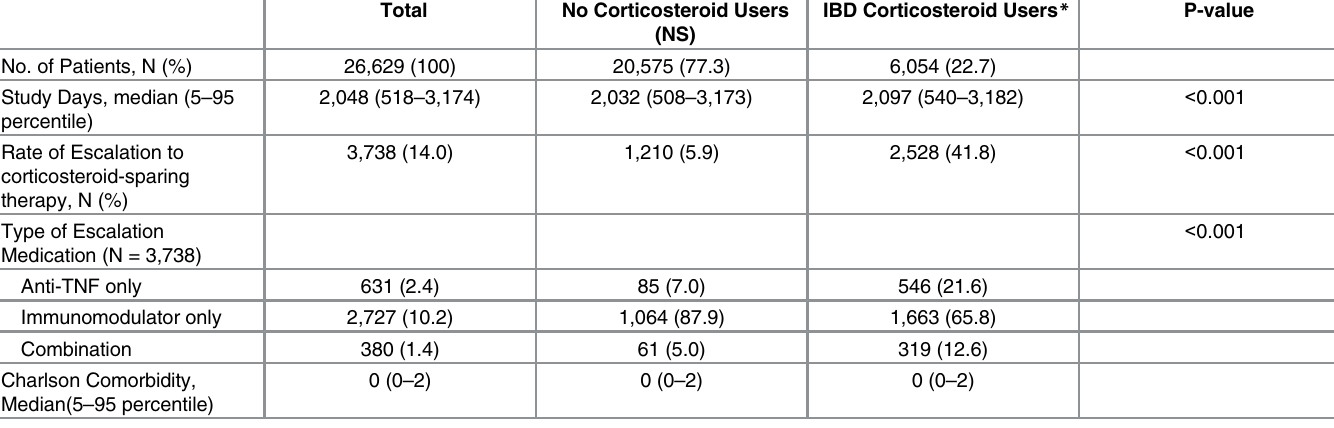
Table 2. Corticosteroid user characteristics among Veterans with and without corticosteroids for IBD only.